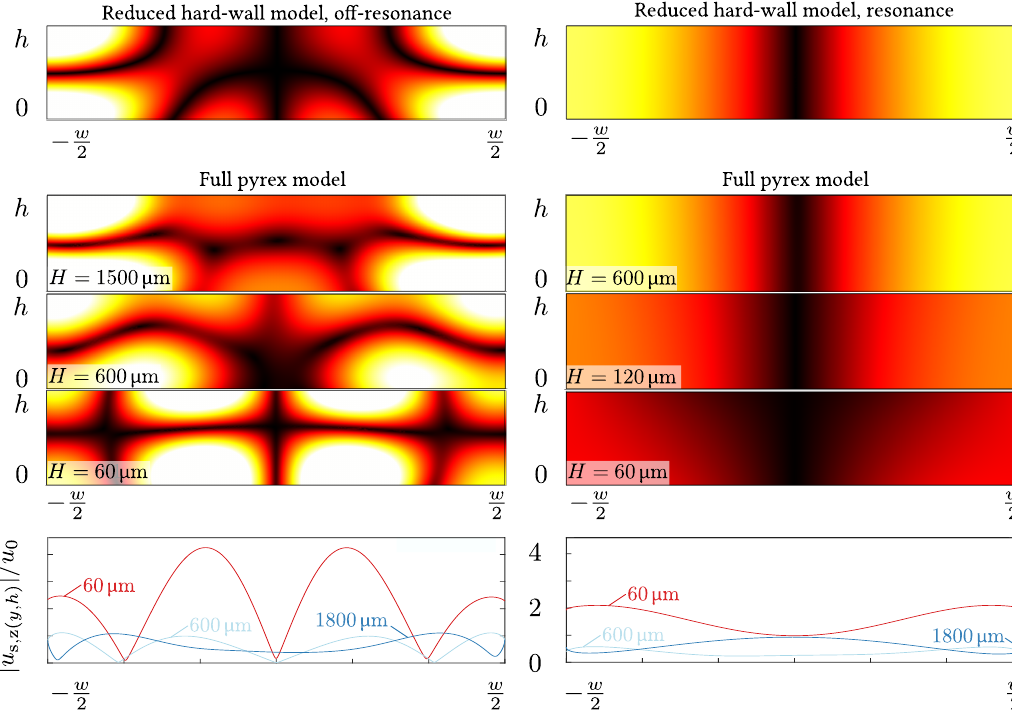
Figure 3. Left column: color plots from 0 kPa ( black ) to 40 kPa ( white ) at the off-resonance frequency f off = 6.65MHz of the amplitude | p f | of the first-order pressure field p f in the fluid domain of the reduced hard-wall model and the full pyrex model Figure 1a, but with H = 60, 600, and 1500µm. The surrounding pyrex is not shown. Right column: the same as to the left, but at the on-resonance actuation frequency f = 1.24MHz and with the color plots ranging from 0 kPa ( black ) to 80 kPa ( white ). Bottom row: off- and on-resonance line plots of the amplitude | u s , z ( y , h ) | of the vertical displacement along the top fluid-solid interface at z = h normalized by the amplitude u 0 of the SAW actuation displacement for wall thickness H = 60, 600, and